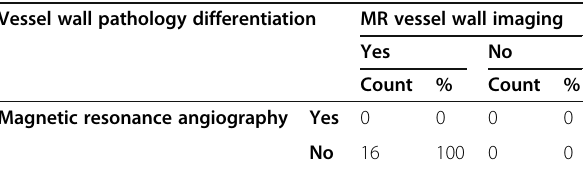
Table 4 Comparison between MRA and MR vessel wall imaging in the ability to differentiate vessel wall pathology among the studied